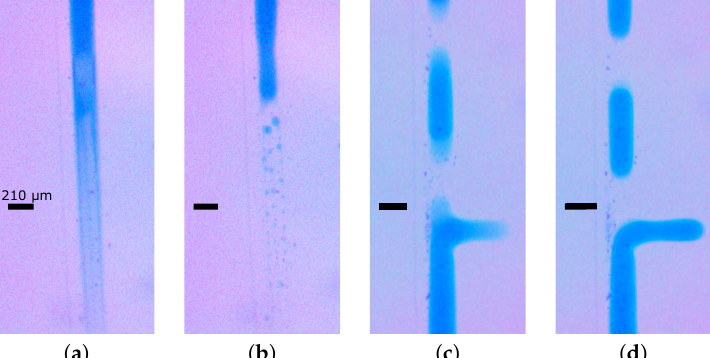
Figure 3. The transient effects of the pumping cycle can be seen in successive video frames to have a large effect on the stability of the droplets that can be formed with oil/water flows. In all images, the width of the channels is the same, 210 µ m, and a scale bar of this size is shown in each image. ( a ) Shows a blue water droplet just after being moved in a pump cycle where the light blue smear below the droplet is thought to represent the long sheath of coloured water left behind in a step of pressure-driven flow under conditions of high positive pressures (80 kPa). ( b ) One frame later, this large and substantial sheath is seen to have coalesced into discrete satellite droplets that trail the primary droplet. ( c ) Shows a blue water droplet just after being moved under optimal conditions. The gentler pump cycle formed a shorter and less extensive sheath of trailing coloured water. ( d ) One frame later, this smaller and less substantial sheath is seen to have retracted into the primary